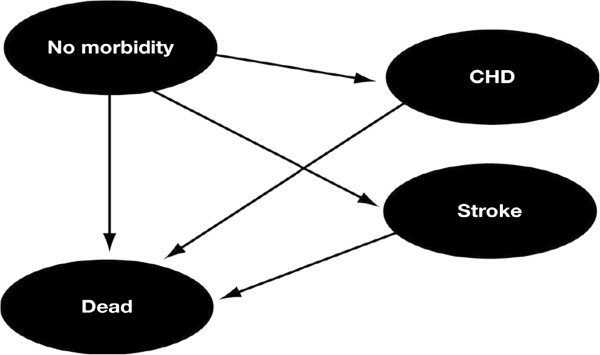
Markov structure for cost-effectiveness model. Possible transitions are indicated by arrows. Diseases considered: CHD, coronary heart disease.